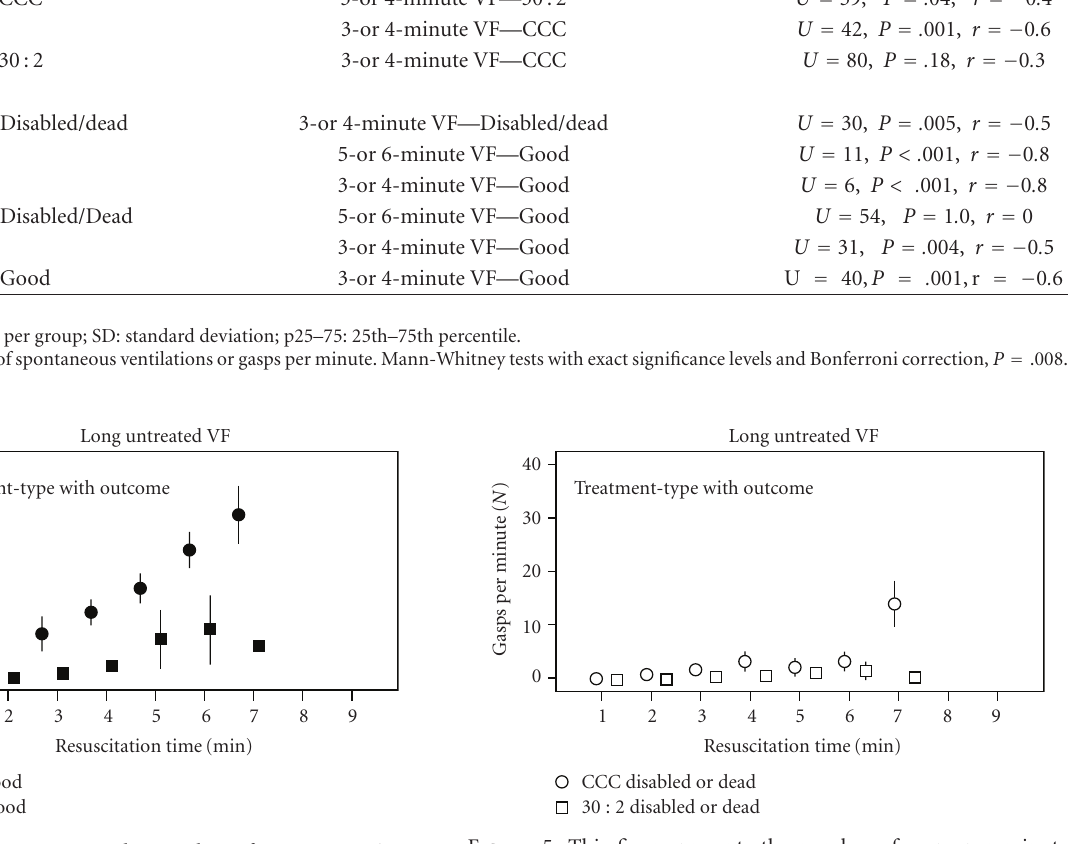
Figure 4: This figure presents the number of gasps per minute (mean ± standard error) plotted against the duration of basic resuscitation e ff orts in animals with good with good 24 hour neurological outcome neurological outcome. Only those animals with 5 or 6 minutes of untreated VF (Long Untreated VF) prior to the onset of basic resuscitation are shown. Circles indicate those treated with continuous chest compression (CCC) basic resuscita- tion; squares indicate those treated with 30:2 basic resuscitation prior to advanced cardiac life support. Standard error is indicated by the vertical lines.